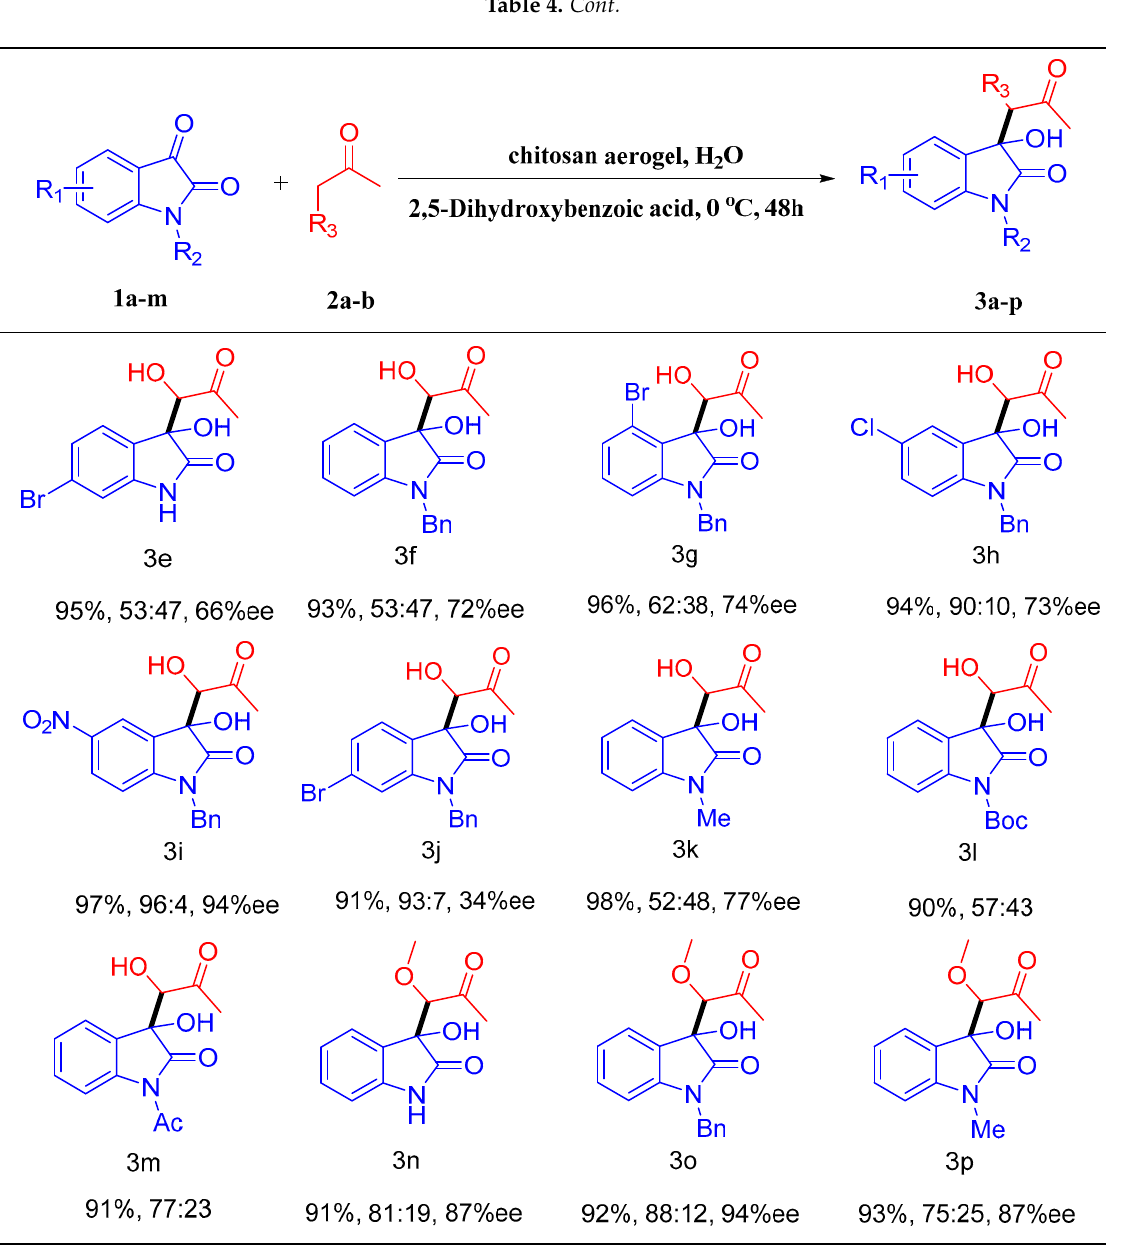
Table 4. Asymmetric aldol reaction between various isatins and ketones catalyzed by chitosan aerogel under optimized conditions abcd . Catalysts 2016 , 6 ,